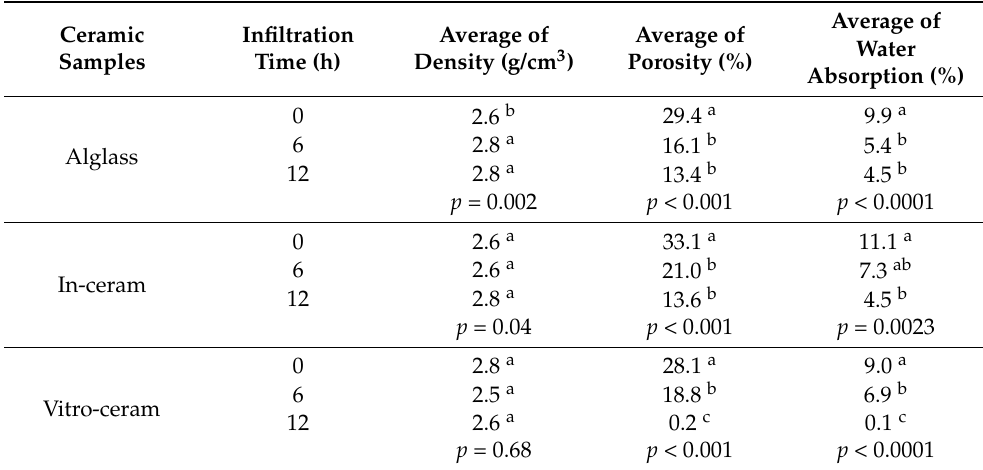
Table 4. Comparison of averages for water absorption, apparent porosity and bulk density of independent samples using Tukey test to the 5% level of statistical